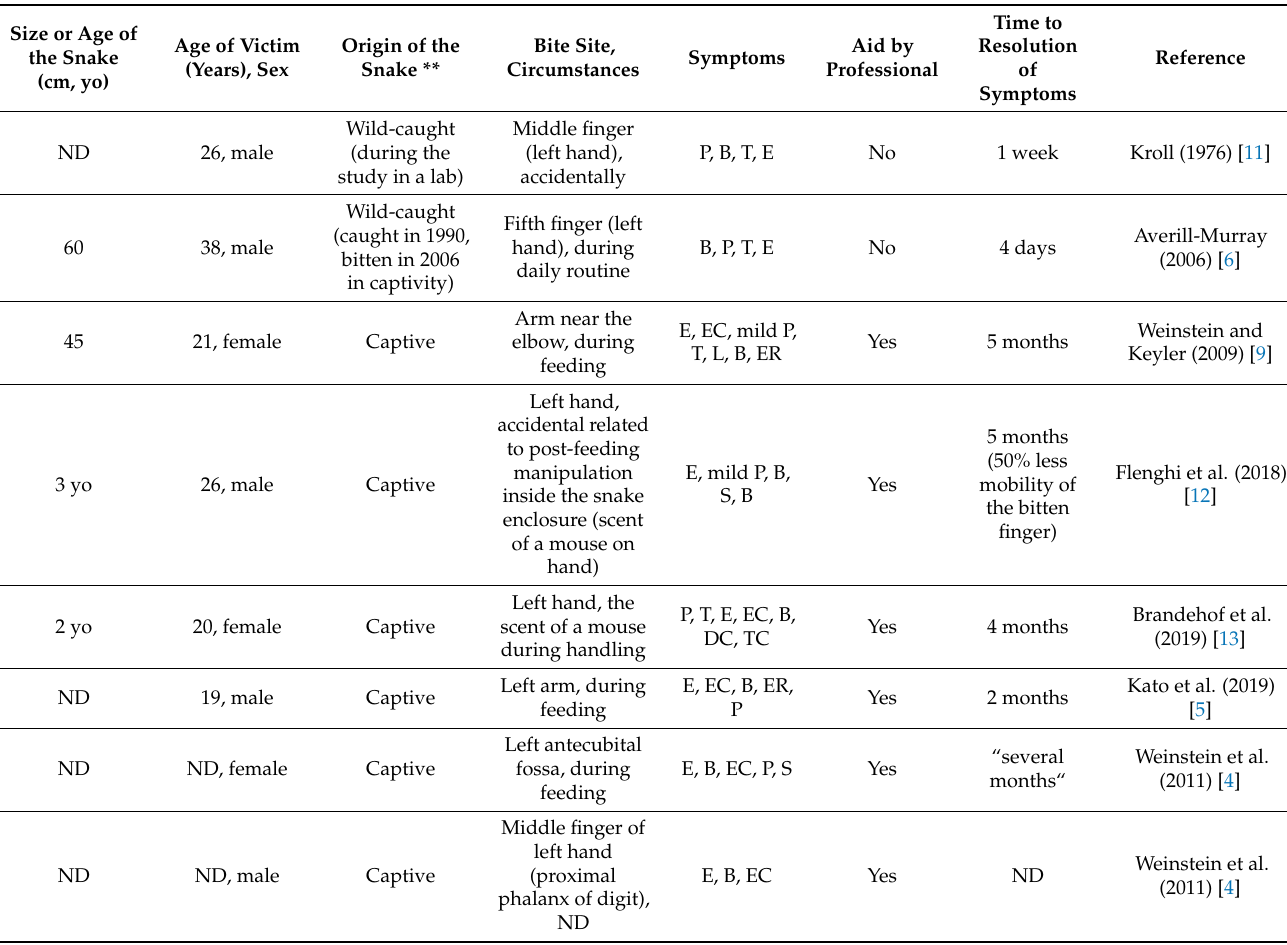
Table 1. Previously * reported cases of Heterodon nasicus bites with detailed information about symptoms, the origin of the snake, bite site, and